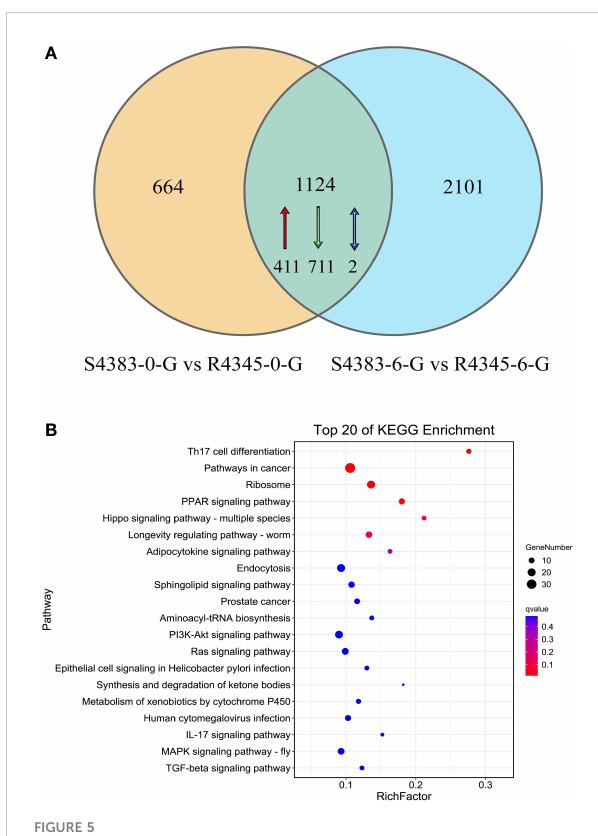
FIGURE 5 DEGs shared between the two comparison groups S4383-0-G vs R4345-0-G and S4383-6-G vs R4345-6-G. (A) Venn diagram showing the numbers of the shared DEGs. Upregulated genes in R4345 are marker with red arrow, down regulated genes in R4345 are marked with green arrows, and the opposite expression trend in R4345 at 0 and 6 h post-infection are marked with blue arrows. (B) KEGG pathway enrichment analysis of the shared DEGs. The y- axis belongs to speci fi c pathway, and the x-axis belongs to enrichment factor. The size and colors of the dots represent the number of genes and q values, respectively (The dots with larger- size indicated a higher number of genes in the